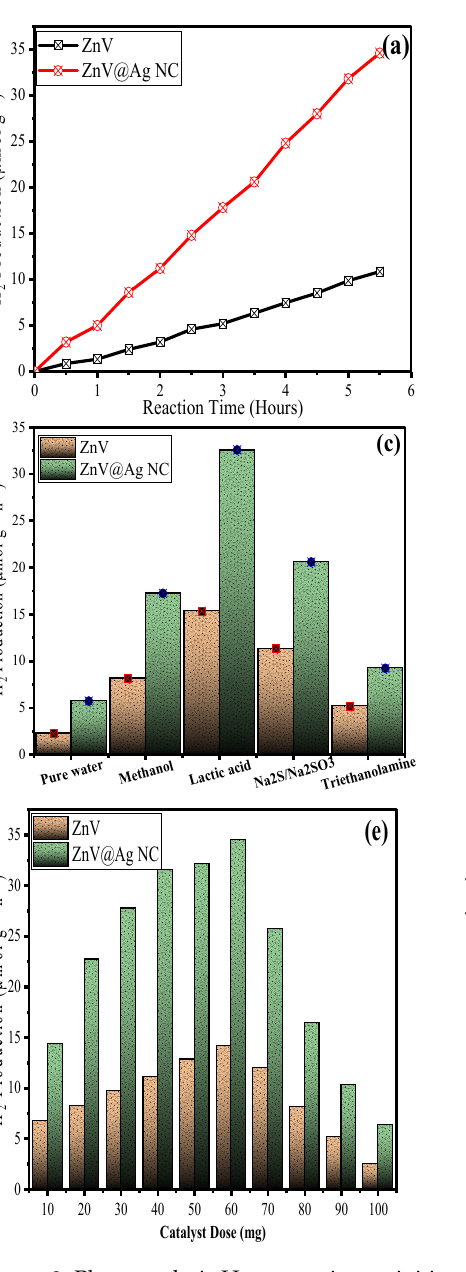
Figure 8. Photocatalytic H 2 generation activities of ZnV and ZnV@Ag NC at different times ( a ), pH values ( b ), and solvents ( c ). Photocatalytic H 2 generation activities of ZnV and ZnV@Ag NC with different doses of catalyst ( d ) and lactic acid ( e ). Stability study of ZnV@Ag NC for H 2 production ( f ). Various amounts (10, 20, 30, 40, 50, 60, 70, 80, 90, and 100 mg) of ZnV and ZnV@Ag NC photocatalysts were used to optimize the photocatalytic performance for effective H 2 generation in lactic acid. The obtained data are summarized in Figure 8d. The obtained results revealed that 60 mg of the photocatalyst has the most effective and efficient pho ‐